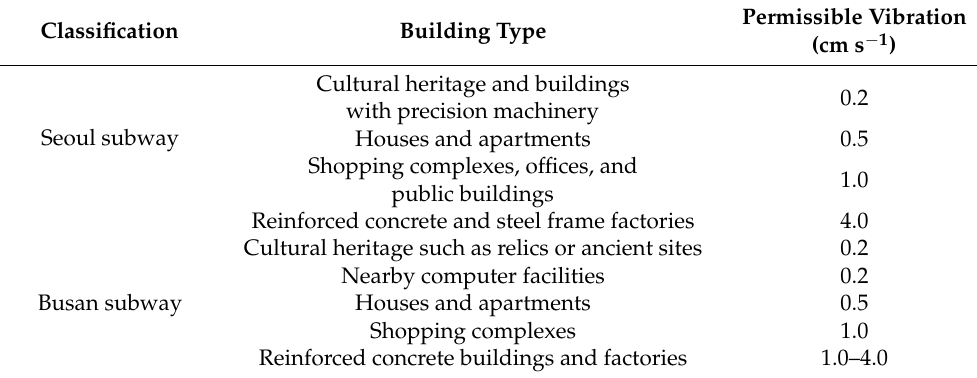
Table 3. Blasting vibration standards for subway construction in Seoul and Busan